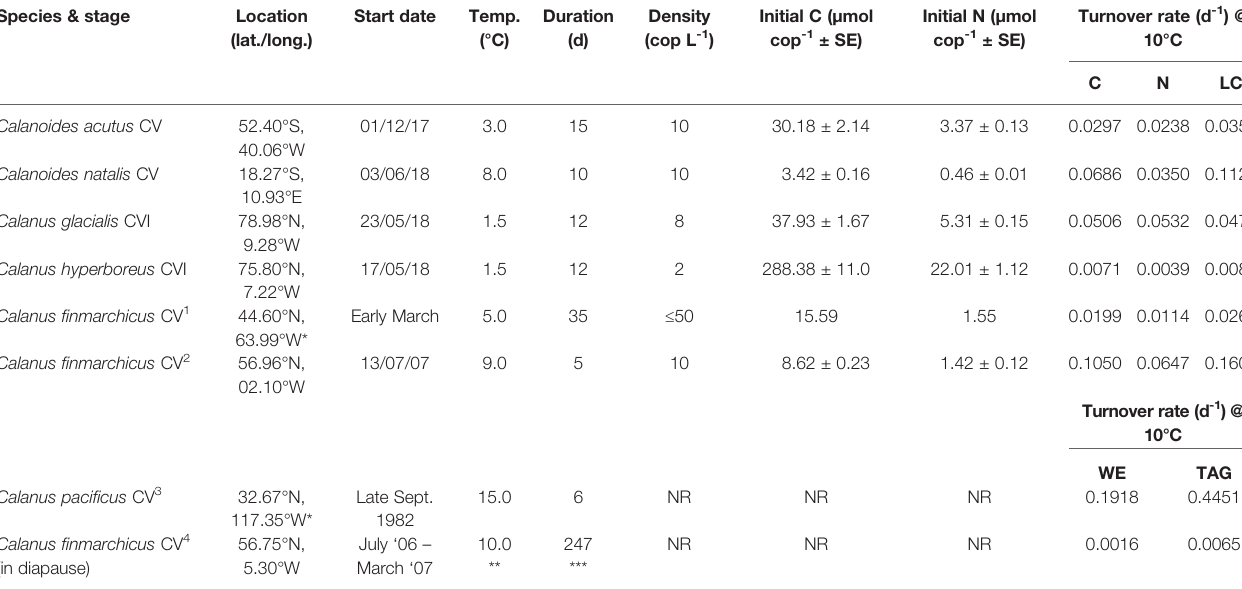
TABLE 1 | Experimental details and biomass turnover rates in food-deprived marine calanoid copepods, normalised to 10°C using Q 10 = 2. Species & stage Location